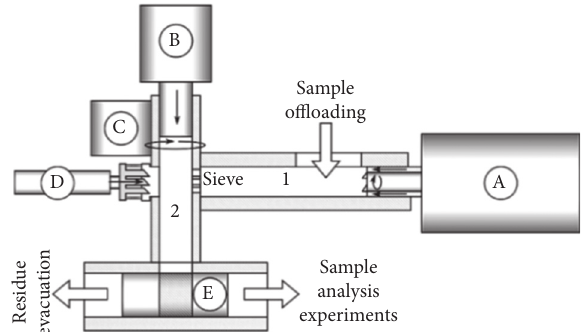
Figure 3: Architecture of